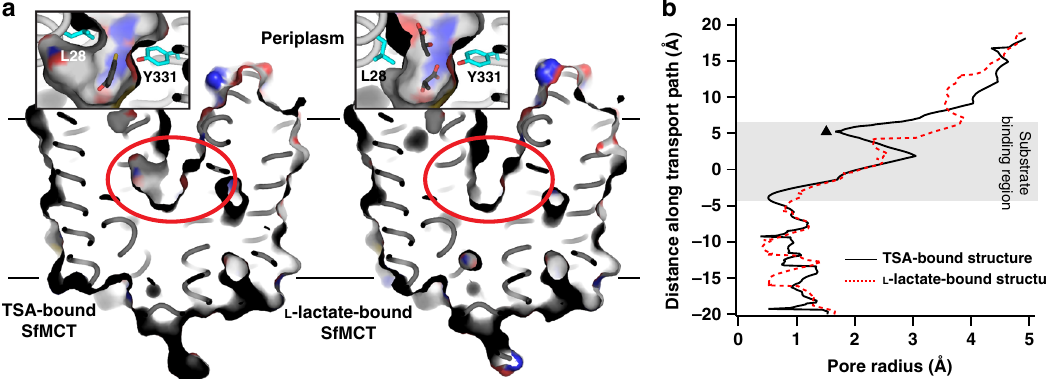
Fig. 4 Analysis of van der Waals surfaces of SfMCT structures. a Cut-open views of structures of TSA (left) and L -lactate (right) bound SfMCT in the outward-open conformation. Insets show the obstruction site (red ellipse) between L28 (TM1) and Y331 (TM10) as well as the bound substrates TSA and L -lactate (insets). In the L -lactate bound SfMCT structure L28 (TM1) is rotated away from the obstruction site. b The van der Waals pore radius as a function of the distance along the transport path was computed using HOLE 50 . Plots represent the pore radii values of TSA (black) and L -lactate (red) bound SfMCT. The triangle highlights the obstruction site between L28 (TM1) and Y331 (TM10)